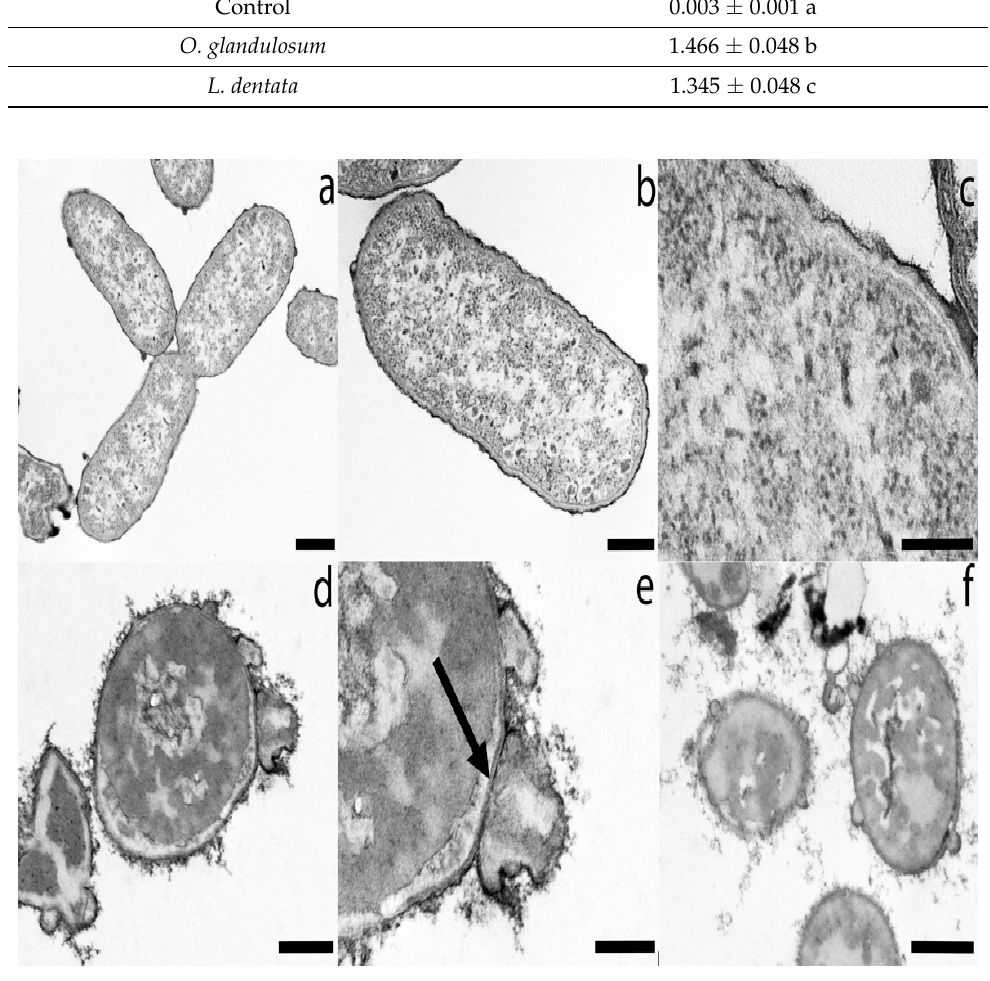
Table 3. Effect of essential oils from L. dentata and O. glandulosum , tested at MIC values (40.6 mg/mL of L. dentata EO; 5.2 mg/mL of O. glandulosum EO) on the release of the 260 nm absorbent material from ESBL K. pneumoniae . Lower case letters denote significant difference at p < 0.05 between sam- ples.